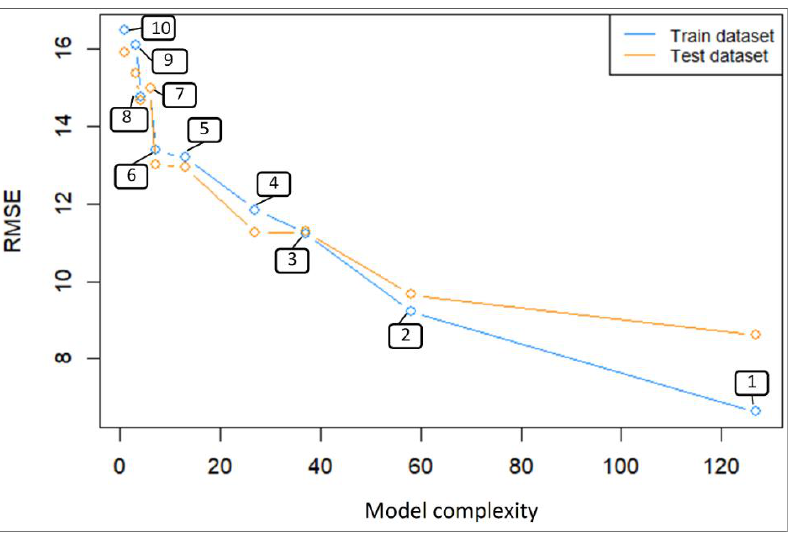
Figure 4. The plot of models RMSE against model complexity on training and test dataset. Each number in the square represents the model number, as shown in Table 5.